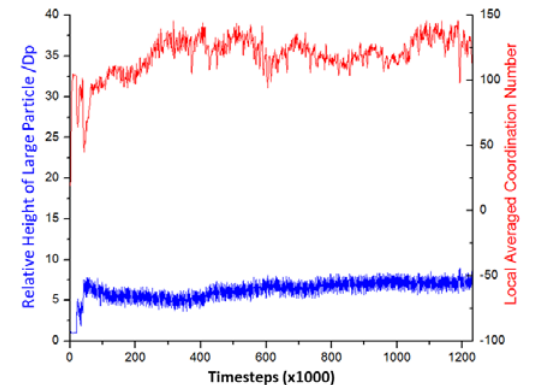
Fig. 3. Time evolution of the relative height of large particle associated with its LACN. Vibration frequency: 50 Hz; Vibration amplitude: 10 mm. Fig. 4. Time evolution of the large intruder ′ s vertical position